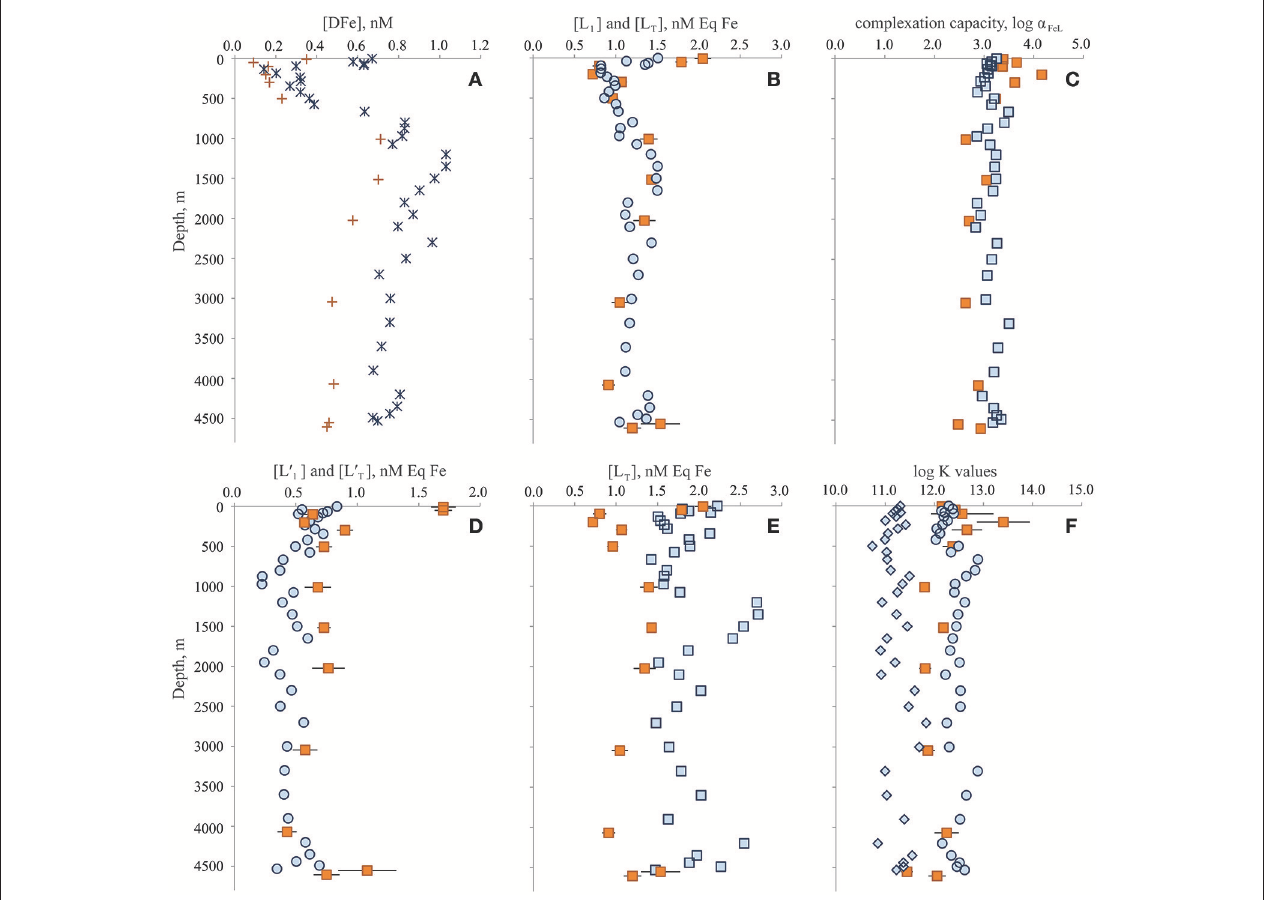
FIGURE 2 | Dissolved iron (Fe) speciation results from the Dutch GEOTRACES GA02 BATS occupation in June 2010 (orange symbols) and from the U.S. GEOTRACES GA03 BATS occupation in November 2011 (blue symbols). (A) Dissolved Fe concentrations; (B) L 1 -type (circles) and total (squares) ligand concentrations; (C) log complexation capacity of organic ligand pool; (D) excess L 1 -type (circles) and excess total (squares) ligand concentrations; (E) total ligand concentrations; and (F) log conditional stability constants of L 1 -type (circles), L 2 -type (diamonds) and single (squares) ligand classes. Symbols for the results are specific to ligand class: circles for stronger L 1 -type ligand class (2011 only), diamonds for weaker L 2 -type ligand class (2011 only), and squares for total (2011) or single (2010) ligand characteristics. Concentration units for ligands are provided as nanomolar equivalents of DFe concentrations (nM Eq Fe). Conditional stability K cond and are presented as log K and log K i , respectively, where i denotes ligand class (units of K: M − 1 ). Error bars represent standard errors constants K cond FeL i , Fe ′ FeL , Fe ′ of the reported